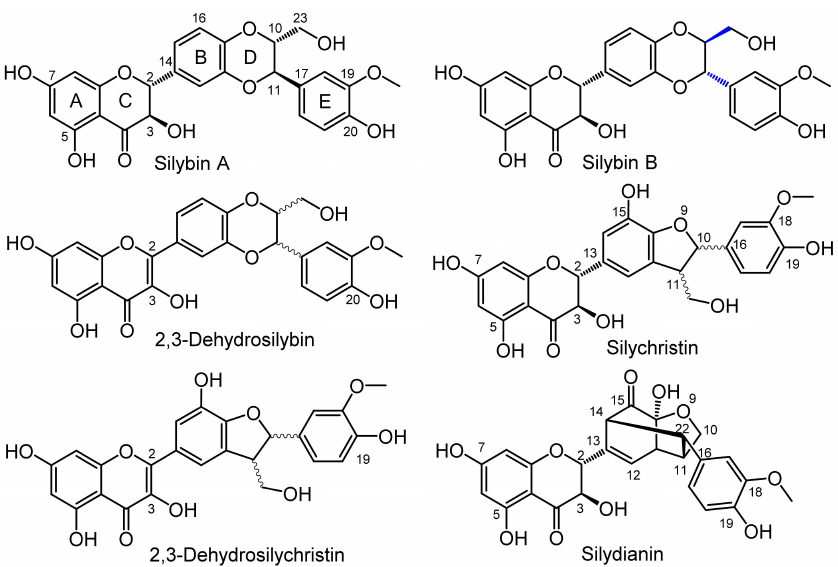
Figure 1. Structures of silymarin flavonolignans used in the study. The structural difference between silybin A and B is shown in